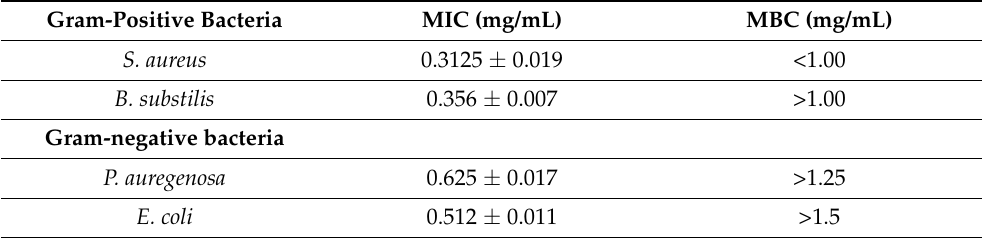
Table 3. MIC and MBC values for PHELA ® extract.